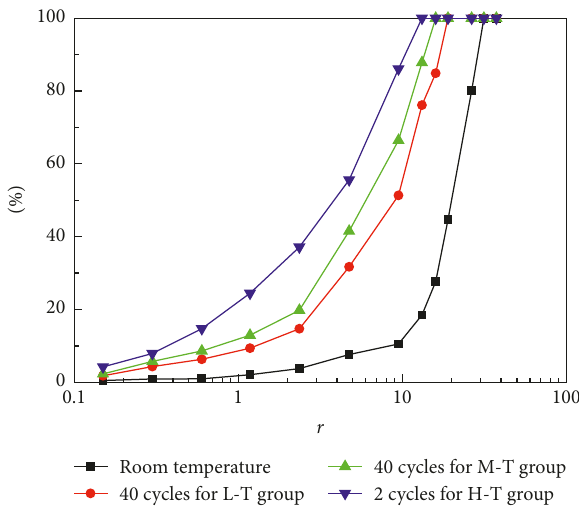
Figure 12: Typical grading curves of rock specimen.